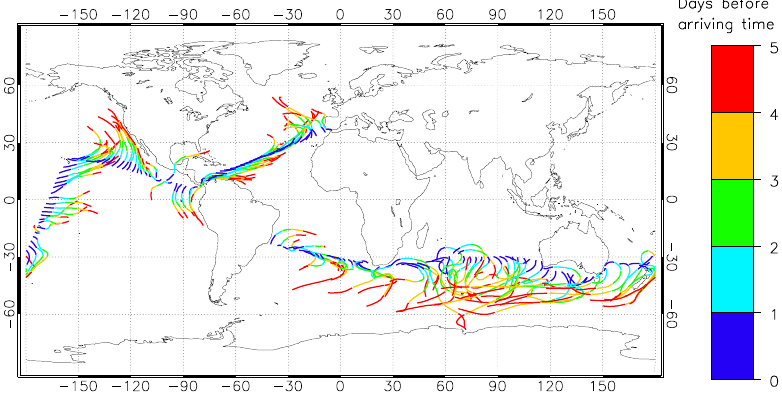
Figure 2. Backward trajectories of the air masses arriving at noon on every day of the Malaspina expedition. They were calculated using HYbrid Single-Particle Lagrangian Integrated Trajectory (HYSPLIT; Draxler and Rolph,